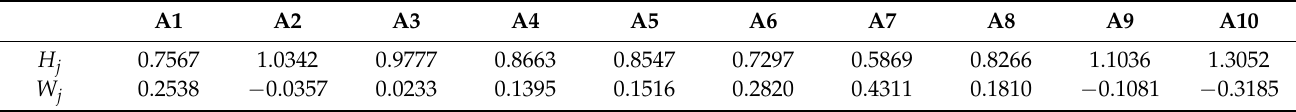
Table 7. Entropy value and entropy weight of risk factors.